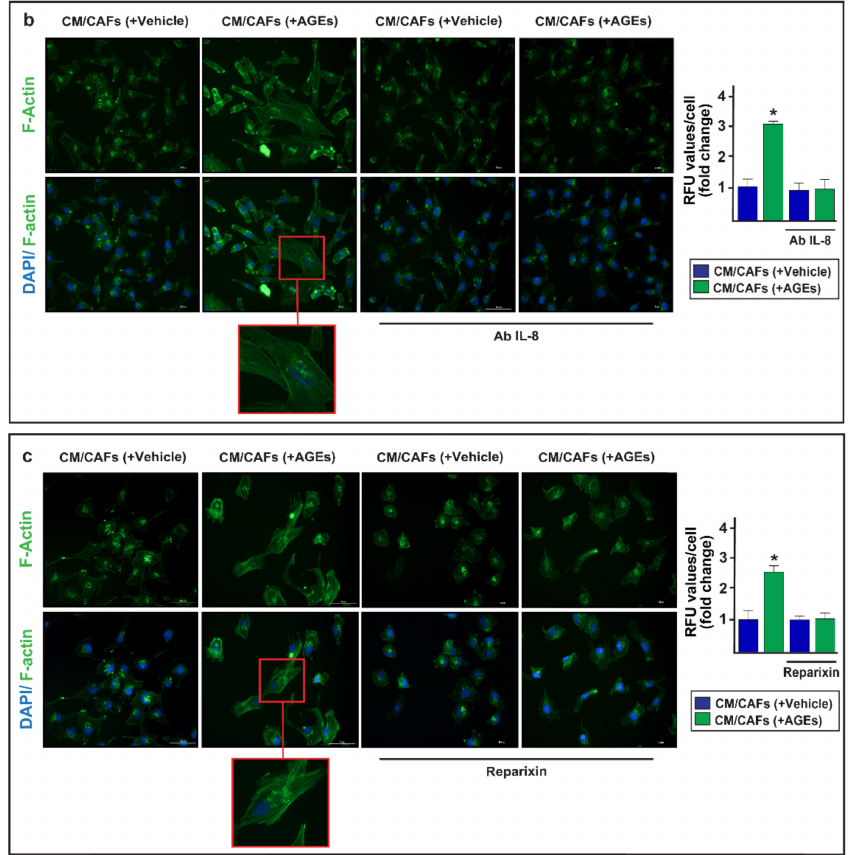
Figure 5. The paracrine action of IL-8 promotes the formation of actin stress fibers in MDA-MB-231 cells. ( a ) MDA-MB-231 cells, which were treated for 6 h with conditioned medium (CM) from CAFs exposed to vehicle or 100 µ g/mL AGEs alone and in the presence of 1 µ M RAGE inhibitor FPS-ZM1, were stained with FITC-conjugated phalloidin to visualize F-actin stress fibers (green) and DAPI to detect nuclei (blue). The F-actin stress fibers formation in MDA-MB-231 cells promoted by CM collected from CAFs previously treated with 100 µ g/mL AGEs, was abrogated using 300 ng/mL IL-8 neutralizing-antibody (Ab IL-8) ( b ) or 5 µ M CXCR1/2 inhibitor reparixin ( c ). Fluorescence intensities of the number of fibers/cell was quantified by F-actin staining in 10 random fields for each condition; results are expressed as fold change of relative fluorescence units (RFU). Data shown represent the mean ± SD of three independent experiments performed in triplicate. (*) indicates p < 0.05. Enlarged details are shown in the separate boxes. Scale bar 100 µ